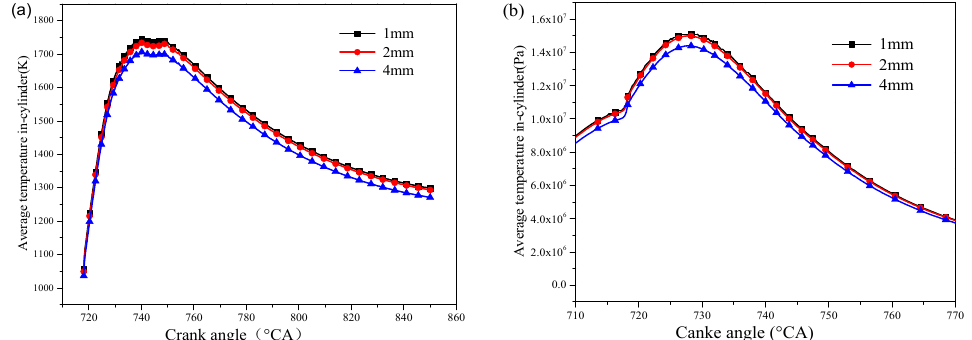
Figure 2. Comparison of calculation results for different grid sizes. (a) Change curve of average in- cylinder temperature; (b) Change curve of average in-cylinder pressure.